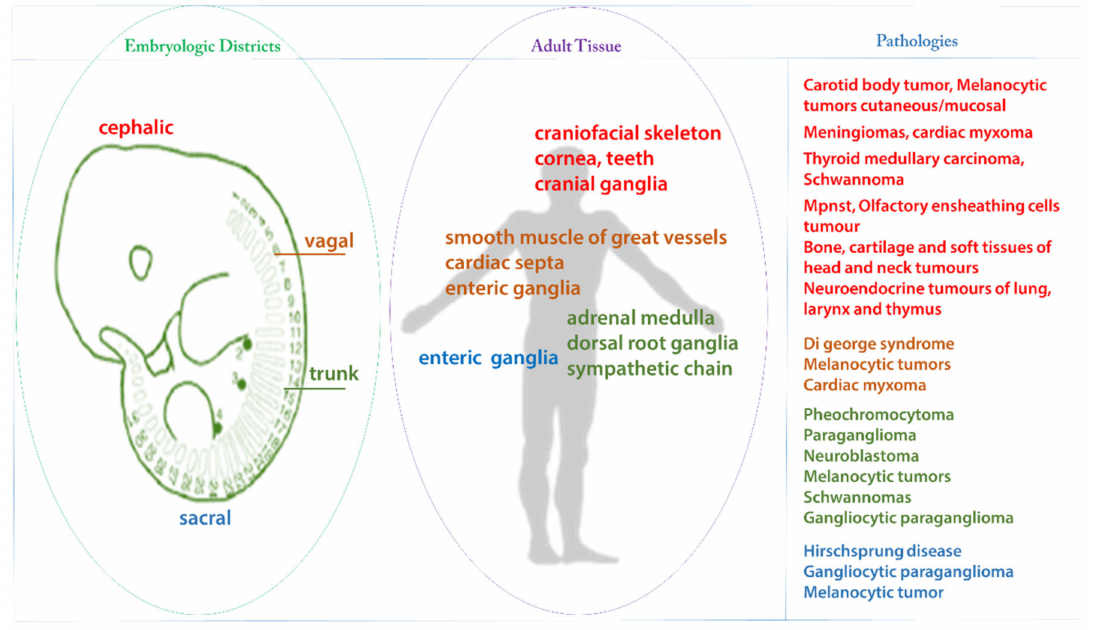
Figure 1. Segments of neural crest with relative adult tissues and pathologies